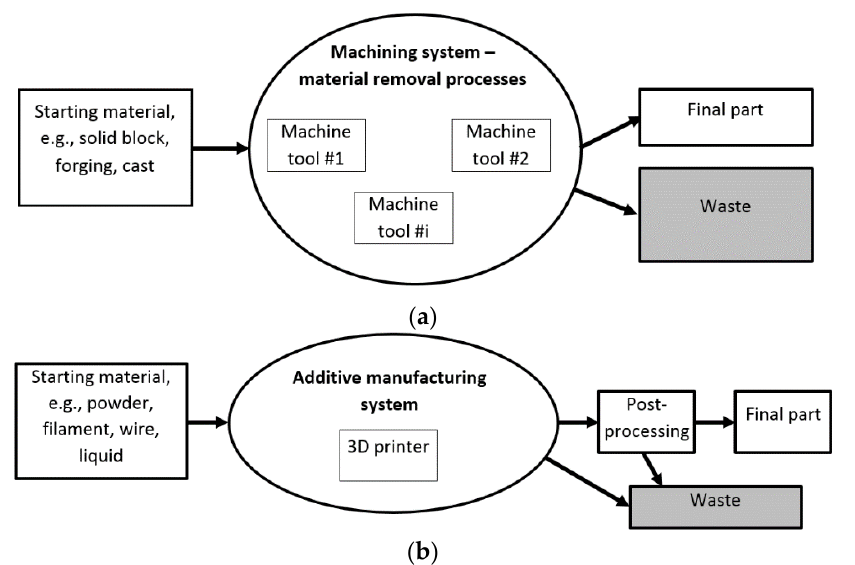
Figure 1. Schematic diagrams of the subtractive manufacturing process ( a ) and the additive manu- facturing process ( b ).